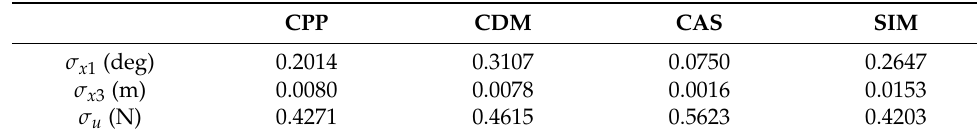
( b ) Figure 17. CIP steady-state performance with a disturbance input using SIM controllers. ( a ) Maxi- mum absolute values of the pendulum angle and cart position; ( b ) maximum absolute values of the control input signal. Remark 7. This paper does not address the measurement noise issue explicitly. The experience with the cascade MPC controller in [17] suggests that low and moderate measurement noises are not problematic, and simple low-pass filtering can be used. This is also favored in [33]. However, high measurement noises present a challenge to the implementation of linear static state-feedback controllers. The problem lies in the need for differentiation of the pendulum angle and the cart position w.r.t. time. In such a situation, it is useful to consider sophisticated differentiations or other controller structures such as the output-feedback controller with or without observers to per- form more efficient noise filtering at the price of an increase in controller design complexity.